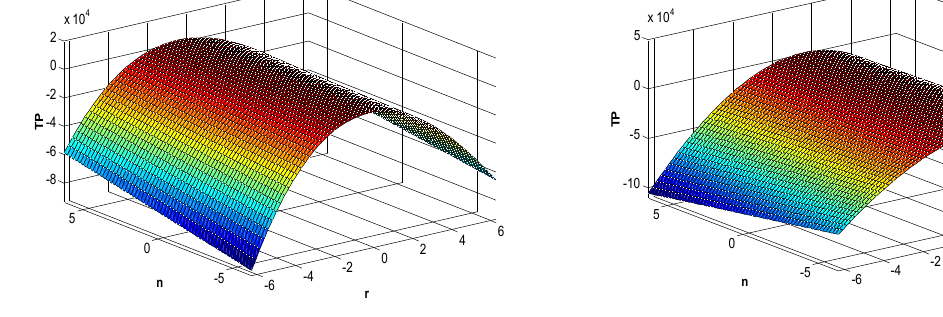
Fig. 4. Net profit in Case (I) Fig. 5. Net profit in Case